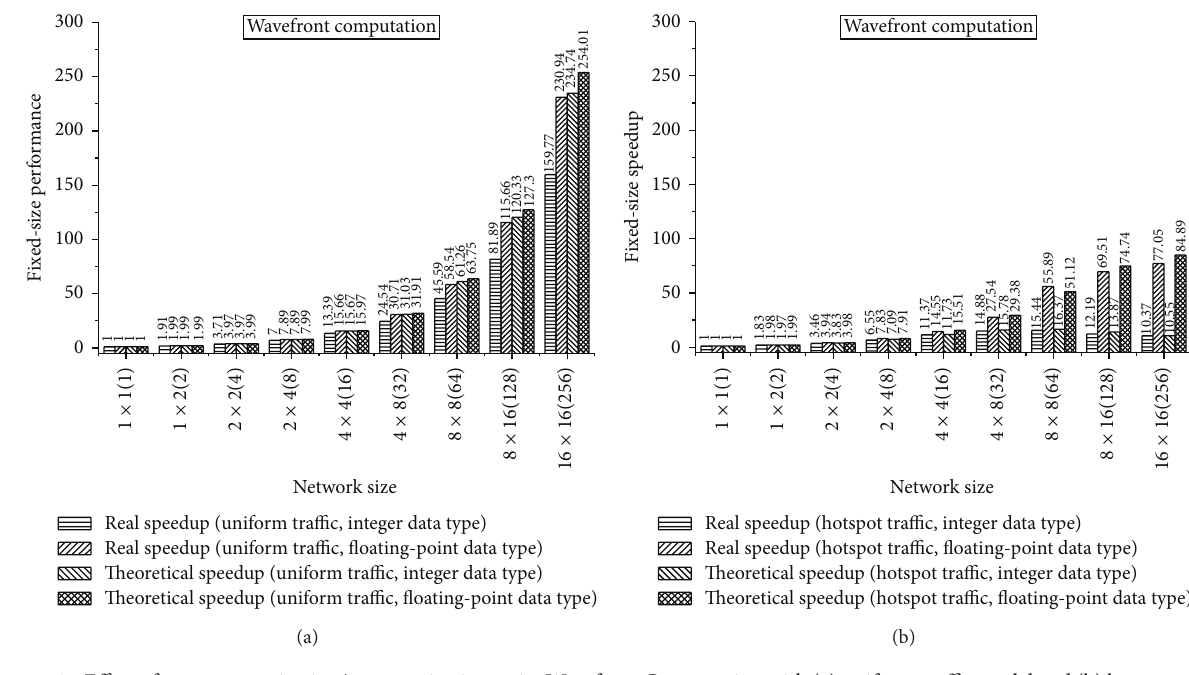
Figure 15: Effect of noncommunication/communication ratio: Wavefront Computation with (a) uniform traffic model and (b) hotspot traffic model.